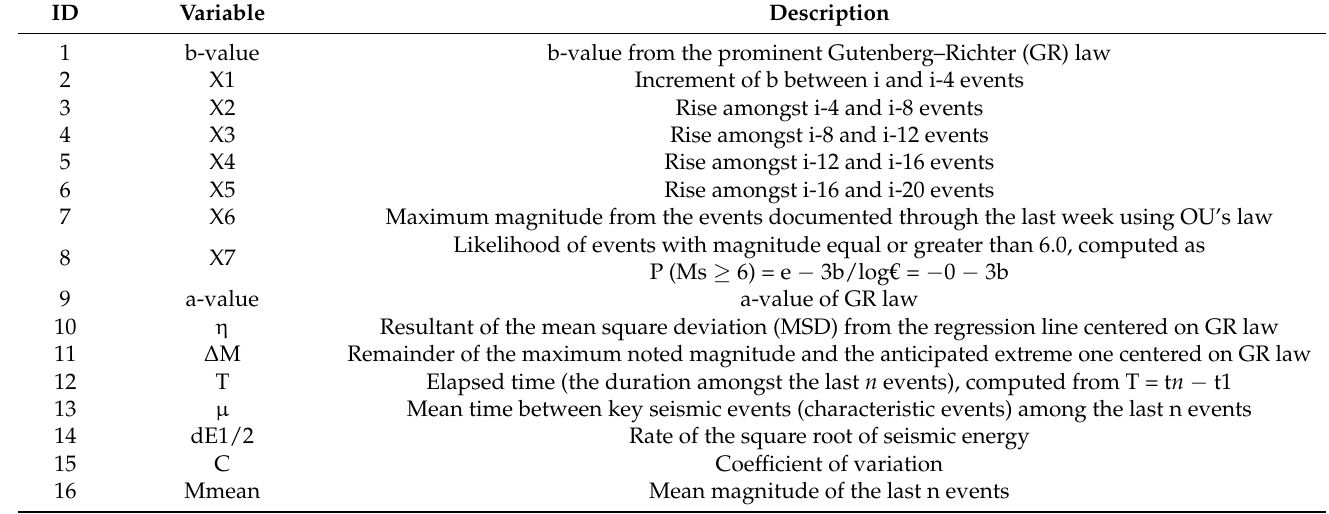
Table 3. Description of the used seismic variables (adopted from